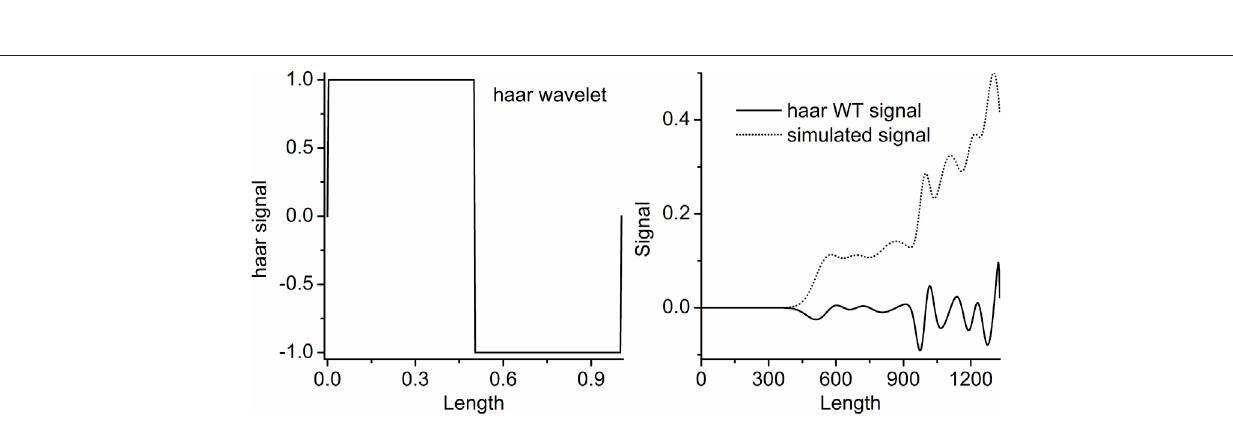
FIGURE 2 | a: the simulated signal S; b – g: the WT results of S by different wavelets with different scales.